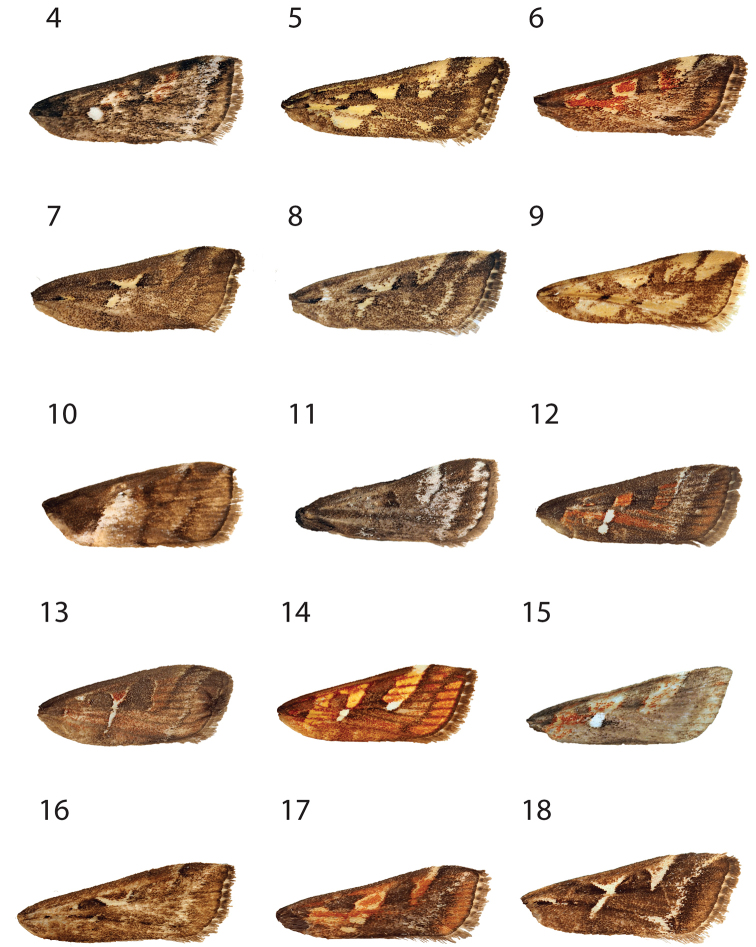
Forewing of Hoploscopa species. 4Hoploscopa
albipuncta sp. nov., holotype, ♂, Malaysia, Sabah, Kinabalu Park HQ, Timpohon Gate, 700 m from Liwagu Trail starting point, near Liwagu River, 6°1'40"N, 116°32'59"E, 1760 m, 18.vi.2015 (T. Léger & R. Mally) (genitalia on slide TL335 ♂) 5Hoploscopa
sepanggi sp. nov., holotype, ♂, Malaysia, Sabah, Mesilau Nature Resort, 6°2'43.71"N, 116°35'48.03'E, 1925 m, at lamps, 30.v.2015 (T. Léger & R. Mally) 6Hoploscopa
cynodonta sp. nov., holotype, ♂, Malaysia, Sabah, Kinabalu Park HQ, junction Kiau View- and Pandanus Trail, 6°0'32.84"N, 116°32'14.94"E, 1690m, UV light, 07.vi.2015 (T. Léger & R. Mally) (genitalia on slide TL327 ♂) 7Hoploscopa
parvimacula sp. nov., paratype, ♀, Sabah, Mesilau Nature Resort, 6°2'43.71"N, 116°35'48.03"E, 1925 m, at lamps, 30.v.2015 (T. Léger & R. Mally) (genitalia on slide TL312 ♀. 8Hoploscopa
kinabaluensis sp. nov., paratype, ♀, Sabah, Kinabalu Park HQ, Timpohon Gate, 700 m from Liwagu trail starting point, near Liwagu River, 6°1'40"N, 116°32'59"E, 1760 m, UV light, 18.vi.2015 (T. Léger & R. Mally) (genitalia on slide TL326 ♀) 9Hoploscopa
luteomacula Nuss, paratype, ♀, Indonesia, Sumatra, Barat, N-Padangpanjang, Mt Singgalang, 2100 m, 10–11.ii.1996 (A. Kallies) (genitalia on slide GU prep. Nuss 743) 10Hoploscopa
obliqua Rotschild, abdomen missing, Papua New Guinea, Madang Province, Wanang village, 05°15'S, 145°17'E, reared from Diplazium
esculentum, 12.vi.2007 11Hoploscopa
niveofascia sp. nov., holotype, ♂, Papua New Guinea, Morobe Prov., nr. Bulolo, Mt. Susu Nat. Res., 975 m, 27–28.viii. 1983, Araucaria For. (S. Miller) (genitalia on slide TL442 ♂) 12Hoploscopa
gombongi sp. nov., paratype, ♂, Papua New Guinea, Yawan village, 06°10'S, 146°5'E, NG Binatang Res. Ctr. (B Gewa, J. Kua, S Sau, A. Kinibel) 13Hoploscopa
tonsepi sp. nov., holotype, ♂, Papua New Guinea, Yawan village, 06°10'S, 146°5'E, NG Binatang Res. Ctr. (J. Valeba, J. Auga, M. Dilu, F. Philip, R. Lilip) (genitalia on slide TL655 ♂) 14Hoploscopa
marijoweissae sp. nov., ♂, Papua New Guinea: Morobe Province, Mount Kaindi, 2350 m, 11.xii.1976 (G. F. Hevel & R. E. Dietz) (genitalia on slide TL437 ♂) 15Hoploscopa
titika sp. nov., holotype, ♂, Sumatra-Holzweg, 25 km SSW-Pematangsiantar, Straße nach Prapat, 13.ii.1996 (A. Kallies) (genitalia on slide TL505 ♂) 16Hoploscopa
pangrangoensis sp. nov., paratype, ♀, Indonesia, Java, Mt. Pangrange, SE Bogor, 6.30S 107.10E, 1625 m, primary forest, 16–20.ii.1996 (Siniaev & Afonin) (genitalia on slide TL627 ♀) 17Hoploscopa
isarogensis sp. nov., paratype, ♀, Philippines, South Luzon, Mt Isarog, 13°40'N, 123°20'E, 530 m, submontane forest, at light, 22.iii.2000 (M. Nuss) (genitalia on slide TL523 ♀) 18Hoploscopa
ypsilon sp. nov., paratype, ♀, Philippines, Luzon, Mountain Province, Chatol, 2100 m, 16–18.xi.1997 (Mey, Ebert & Nuss).